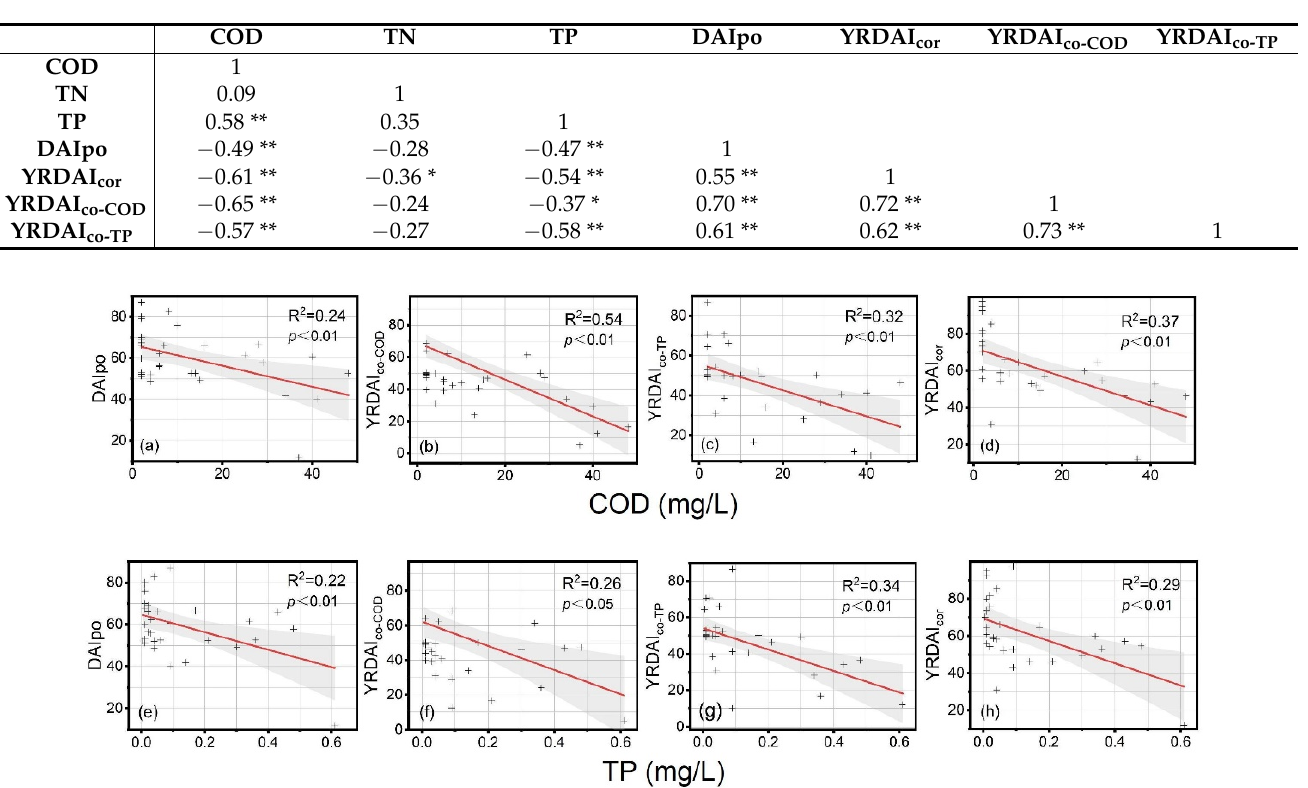
Table 3. Results of correlation analysis quantifying the significance of the relationship between diatom indices and total phosphorus (TP), total nitrogen (TN) and chemical oxygen demand (COD). The symbols * and ** indicate significant correlation at the level of 0.05 and 0.01, respectively.